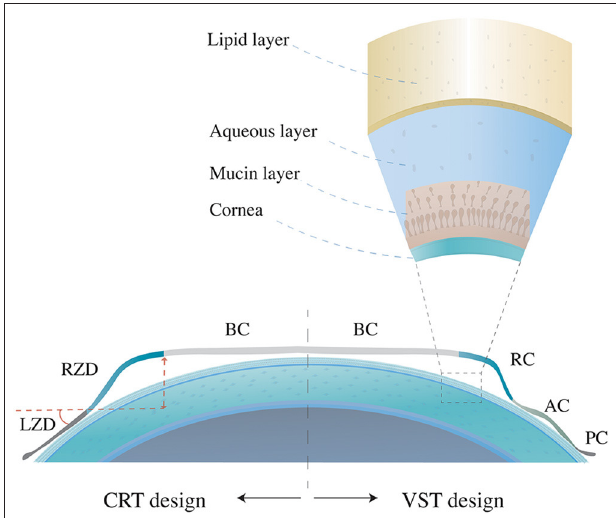
FIGURE 1 | Orthokeratology lenses with different designs and the layers of